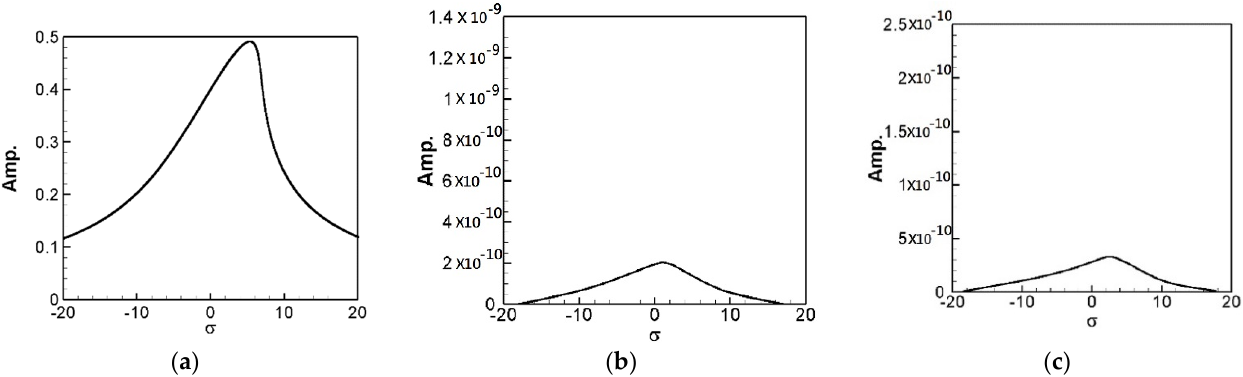
Figure 4. SES system fixed points plots of the 1st mode being excited. ( a ) 1st mode response, ( b ) 2nd mode response, and ( c ) 3rd mode response.